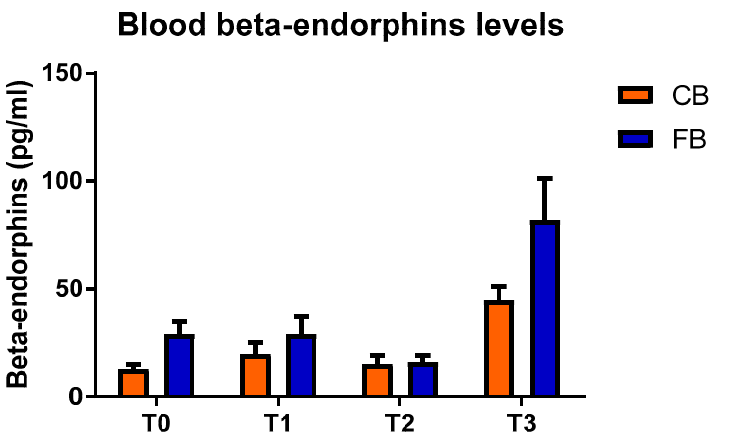
Figure 4. Blood beta-endorphins levels (mean values ± SD) in the compost barn (CB) and the freestall barn (FB) groups. As far as the blood BE levels are concerned, in both the CB and FB groups, there was an increase at T3 when compared to the other experimental times (Figure 5A,B).